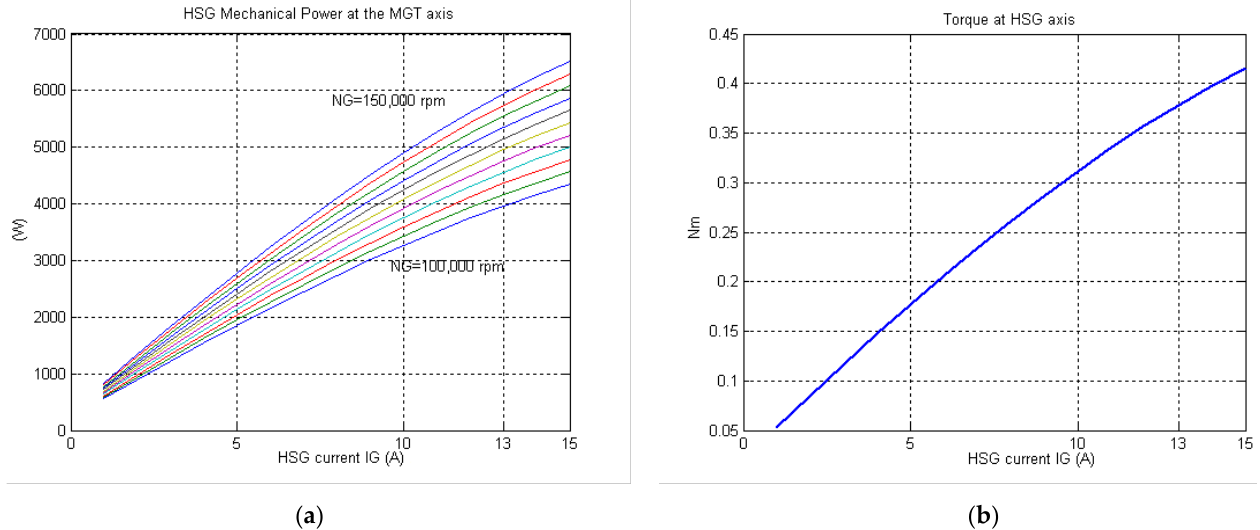
Figure 11. ( a ) Calculated HSG mechanical Power at MGT shaft as a function of the generator current IG, varying the MGT speed from 100 to 150 krpm; ( b ) Calculated HSG Torque at MGT shaft as a function of the generator current IG varying the MGT speed from 100 to 150 krpm.